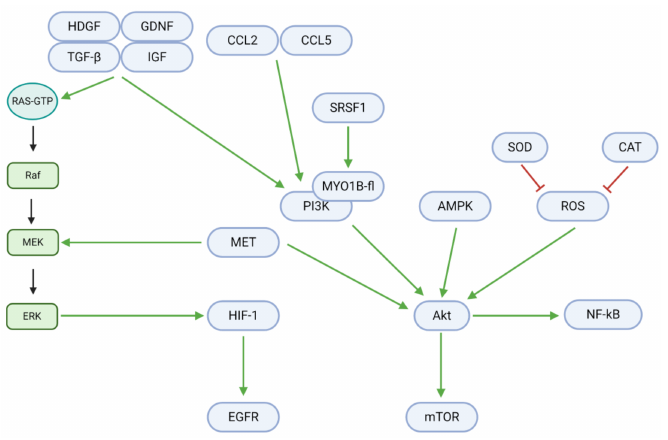
Figure 4. Intracellular mechanisms promoting proliferation in GBM. Growth factors, chemokine ligands, and other upstream signals upregulate the Ras/Raf/MEK/ERK and PI3K/Akt pathways. Downstream effectors, including HIF-1, EGFR, NF- κ B, and mTOR, promote DNA synthesis, tran- scription, and tumor cell proliferation. Proliferative effectors notably engage in crosstalk with other signals in GBM, including those for angiogenesis (HIF-1), cell cycle progression (Akt), metabolism